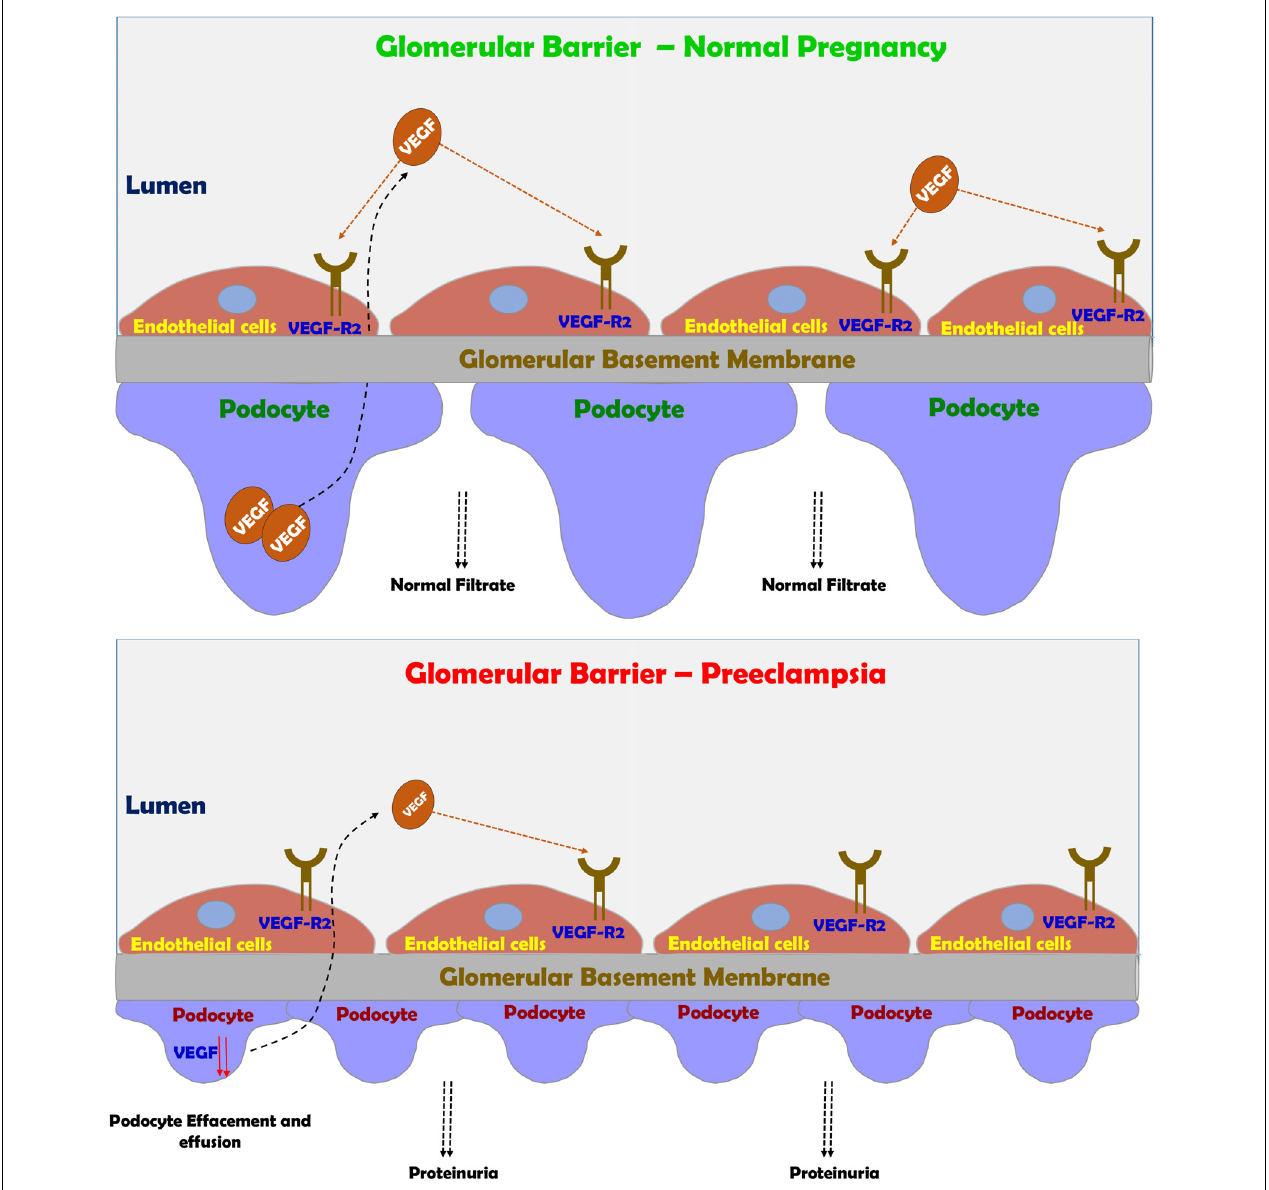
FIGURE 4 | Preeclampsia-induced renal dysfunction. Under normal condition, VEGF plays a central role in maintaining the integrity of glomerular barrier as evident by healthy podocytes with normal foot process and slit diaphragm proteins. Under preeclamptic condition, angiogenic imbalance develops mainly due to sFlt-1 and sEng, leading to podocyte and endothelial damage in the glomerular filtration barrier and subsequently to the development of